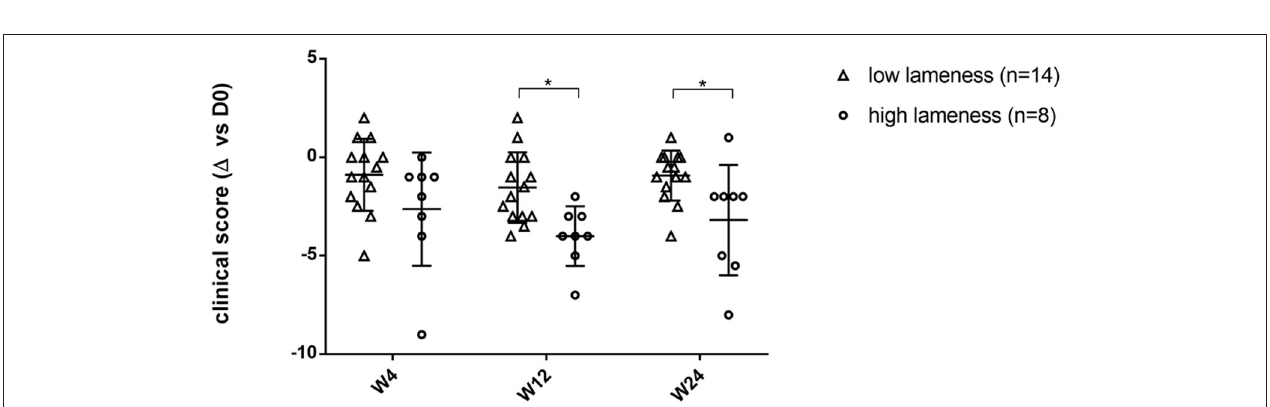
FIGURE 2 | Evolution of clinical scores. * Significant difference ( p < 0.05) between each timepoint and day 0. Data are presented as median and range. (A) Clinical score evolution of all joints; (B) clinical score of the unilateral carpal, tarsal and knee joints; (C) evolution of clinical scores of elbows; (D) evolution of clinical scores of hips. These figures show a improvement of the clinical score throughout the study for all tested joints.